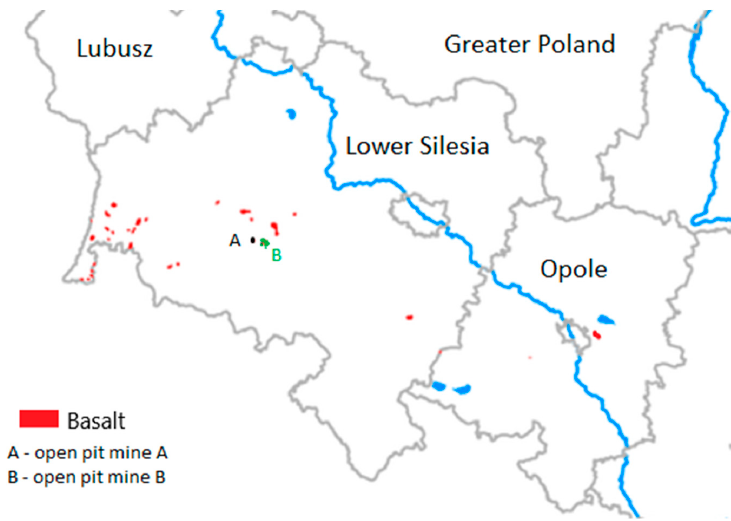
Figure 1. Location of basalt deposits from which basalt dust is obtained in Poland [23].